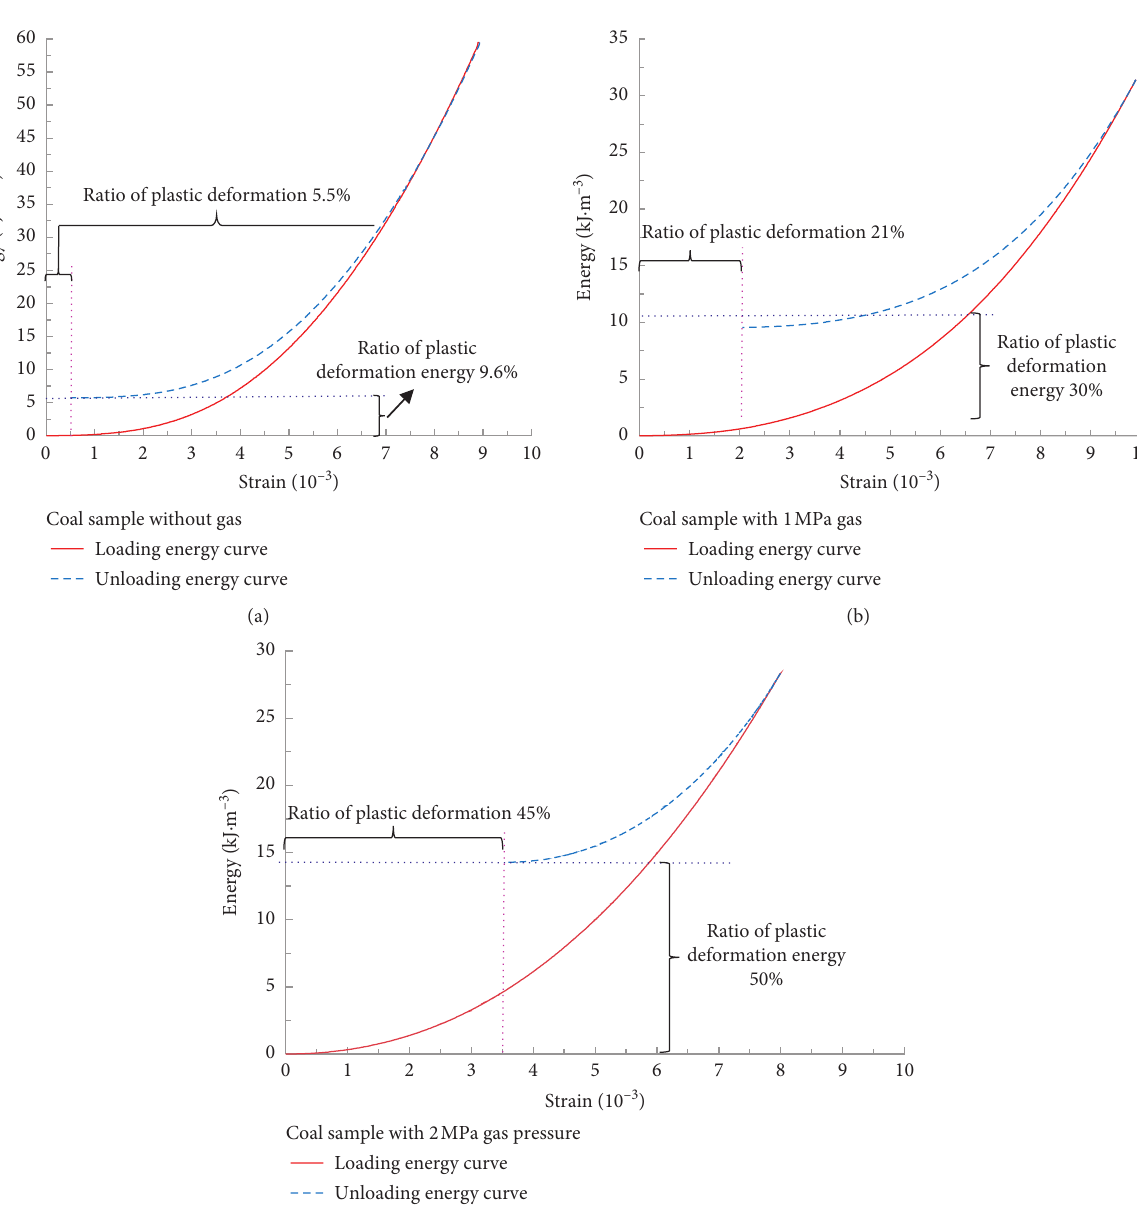
Figure 12: Energy evolution curve of gassy coal during loading and unloading. (a) Coal sample without gas pressure. (b) Coal sample with 1MPa gas pressure. (c) Coal sample with 2MPa gas the sliding and friction between the coal blocks can still produce AE events. table of AE energy signal under uniaxial compression for different gas pressure coal samples, and Figure 15 is the relationship curve of AE energy and AE cu- mulative energy with stress and time under uniaxial compression for different gas pressure coal samples.